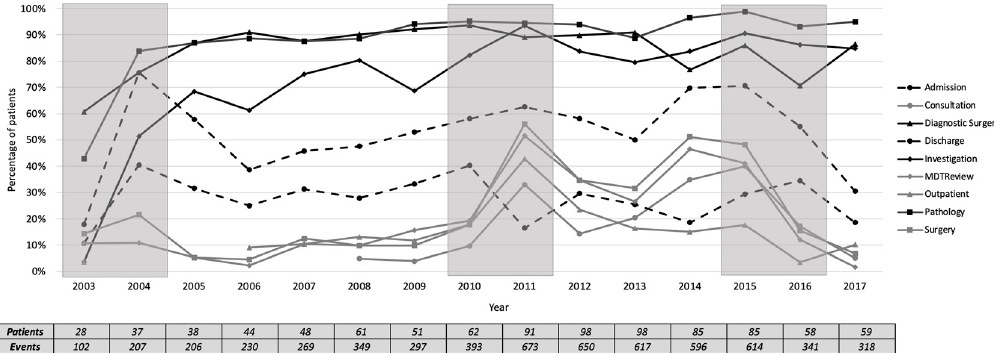
Figure 8. Percentage of activity presence by the number of patients each year. The solid black lines represent frequent activities; the solid grey lines represent infrequent activities and highly varied activities. The shaded areas show the potential change periods at the activity level. Referral and diagnosis occurred in 100% of patients and are not presented for simplicity purposes.